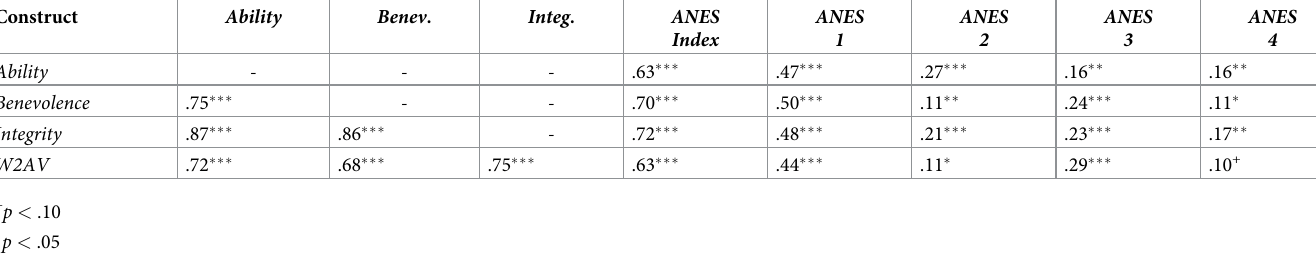
Table 2. Latent and ANES variable